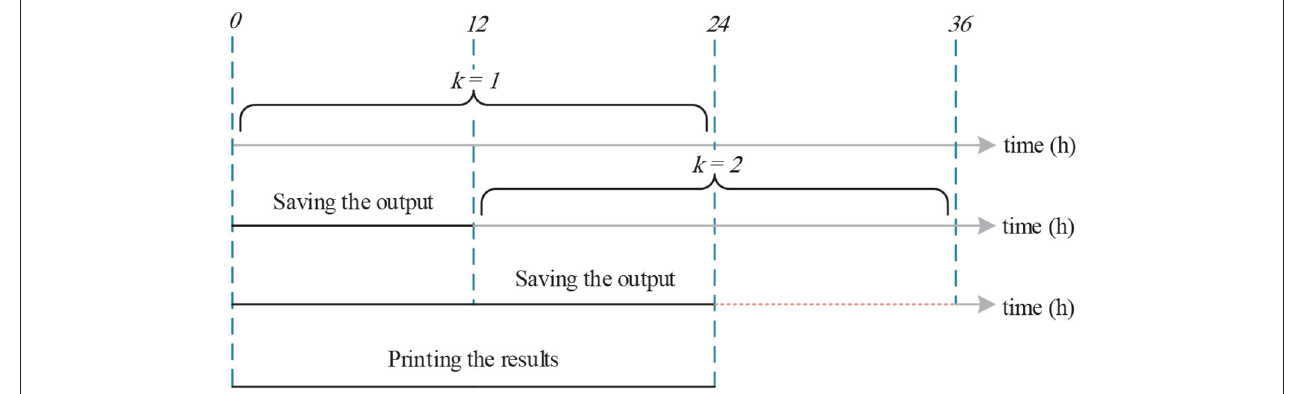
FIGURE 2 | Twelve-hours output saving strategy.